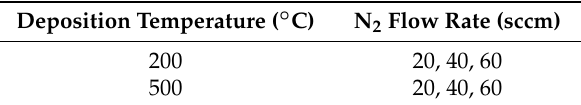
Table 1. Deposition parameters of Ti-Al-N coatings at various process